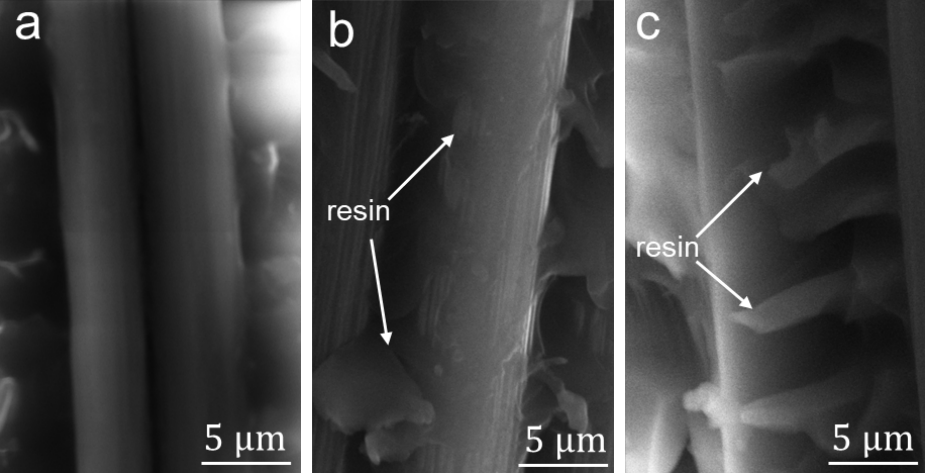
Figure 7. SEM morphology of the fiber surface after a pull-out test: ( a ) CF; ( b ) 5%-K@CF; and ( c ) M-5%-K@CF. The arrows point to the resin left on the CF surfaces.